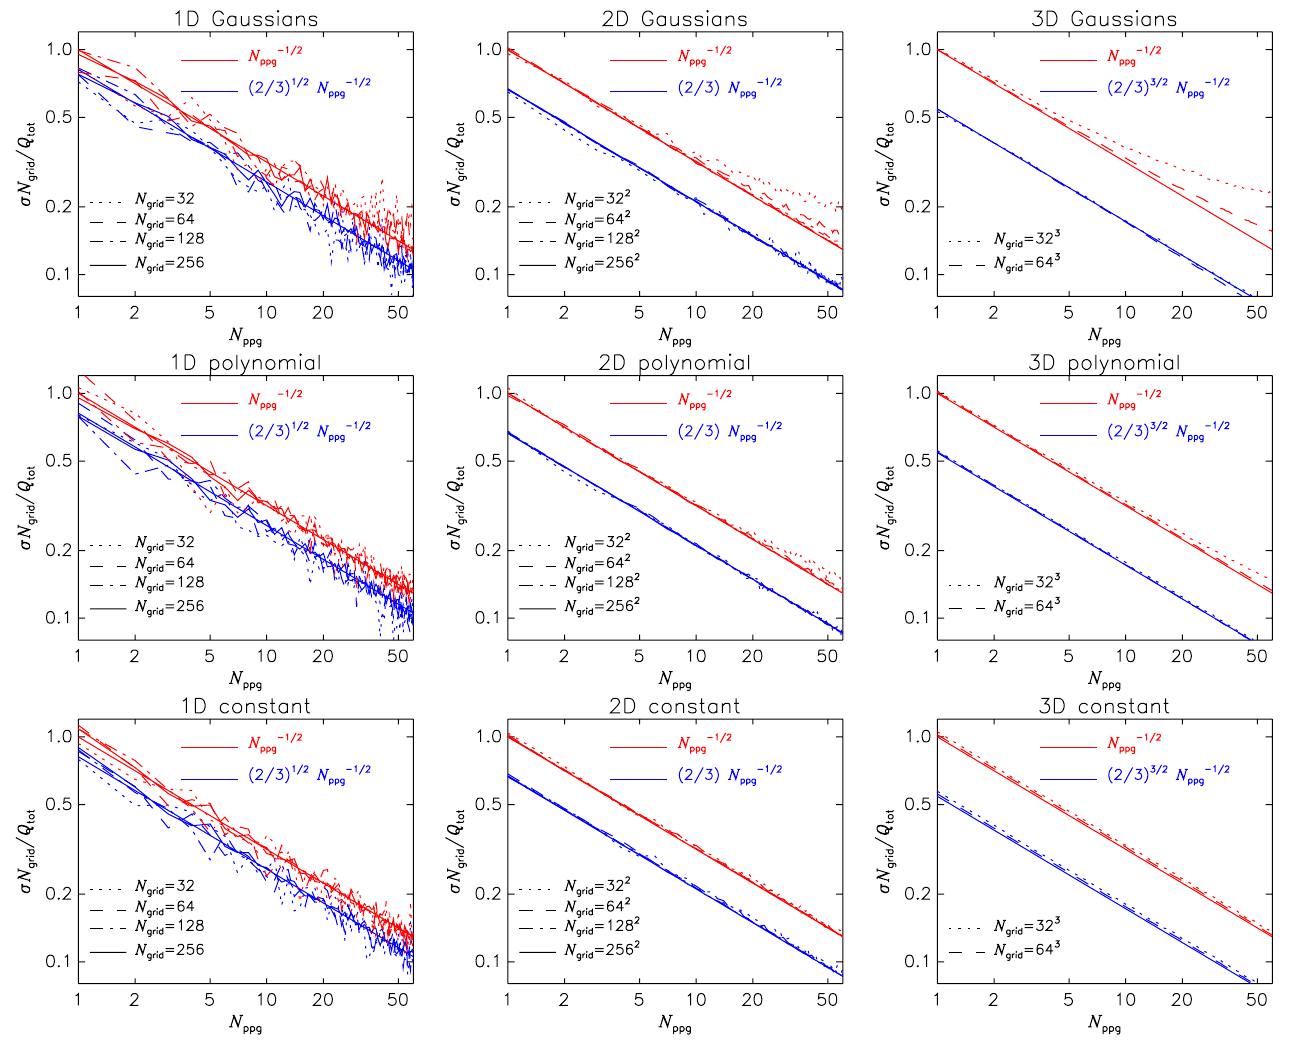
FIG. 8. (Color) For each of the three particle distributions [superimposed Gaussians (top row), polynomial (middle row), and constant (bottom row), in 1D (left column), 2D (middle column), and 3D (right column)], the normalized standard deviation of noise =Q ) for a single random noisy realization as a function of the average number of particles per grid point ( N ( (cid:12)N grid tot represent the NGP DS and blue the CIC